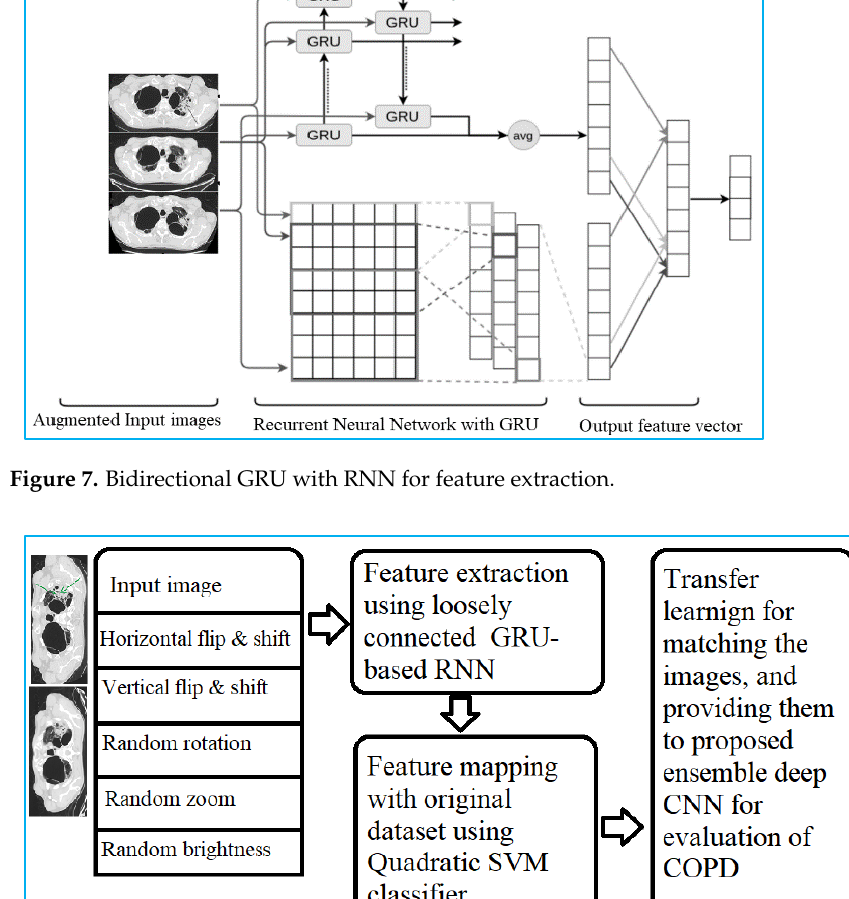
Figure 8. Data augmented transfer learning model for real time COPD classification.